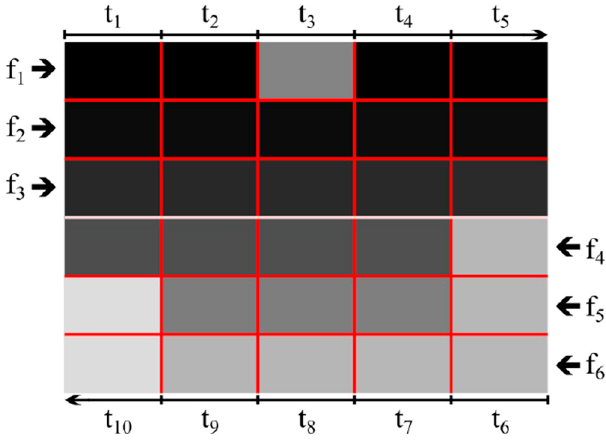
Figure 5. Schematically presented process of sound transmission of the depth. The illustration does not include pauses and reference sound. The arrows marked as fx indicate the “scan” direction and tone, where f1 is the highest frequency tone, and f6 is the lowest frequency tone. Subsequent times of transmitted columns are marked as t 1 –t 10 .